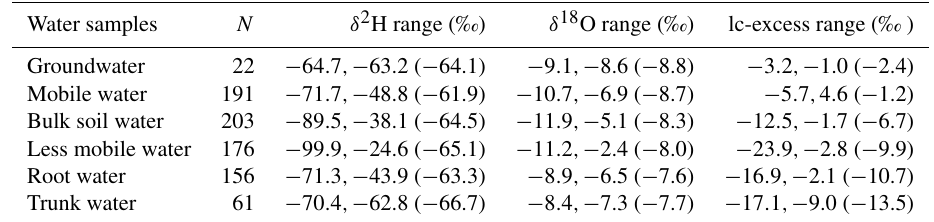
Figure 2. (a) δ 18 O and δ 2 H isotopic compositions collected from 4 August to 15 September 2019. Plotted values include bulk soil water (BW), mobile water (MW), root water (RW), trunk water (TW), less mobile water (LMW) and groundwater (GW). The other plots show the δ 18 O and δ 2 H isotopic compositions of (b) GW and MW collected from different depths, (c) BW collected from different depths, (d) LMW collected from different depths, (e) RW collected from different depths, and (f) TW collected at different tree heights. The red line represents the 2016–2019 local meteoric water line (LMWL, δ 2 H = 5.91 + 7.67 δ 18 O, R 2 = 0.96). The black line represents the global meteoric water line (GMWL, δ 2 H = 10 + 8 δ 18 O). Table 2. Stable isotopes in water (see Fig. 2) and lc-excess values (Fig. 3) for all water samples. Range values show minimum, maximum